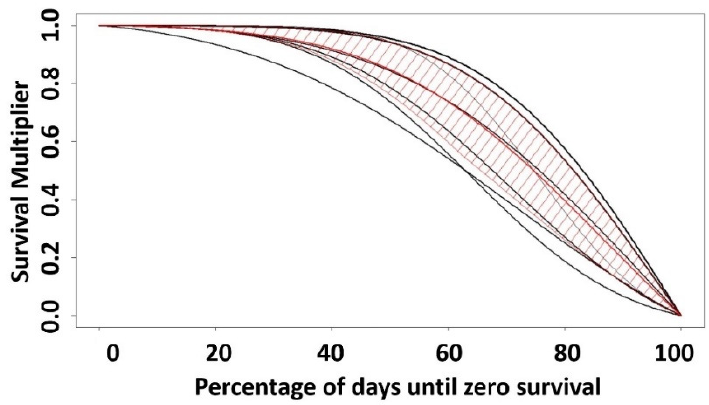
Figure 2. Elicited form of the dose–response function from each of the experts (black lines). Thickness of the line is proportional to the certainty the expert attached to their elicited shape. The red line indicates the weighted mean function, while the shaded polygon indicates approximate 50% central weighted quantiles.